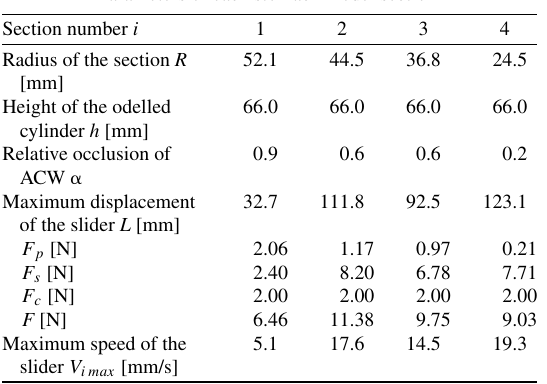
Fig. 6. Model of the springs placed in each